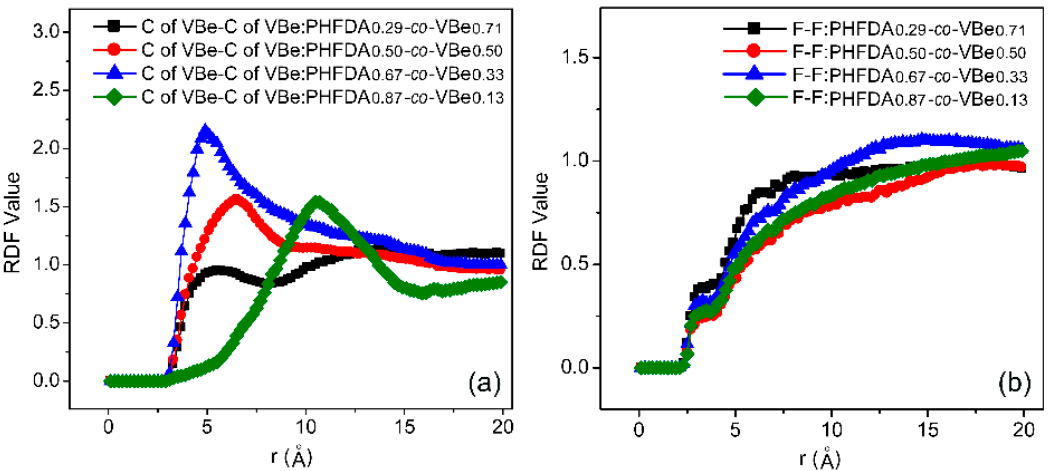
Figure 9. Radial distribution functions of the intermolecular C-C pairs of VBe groups ( a ) and F-F pairs of HFDA groups ( b ).